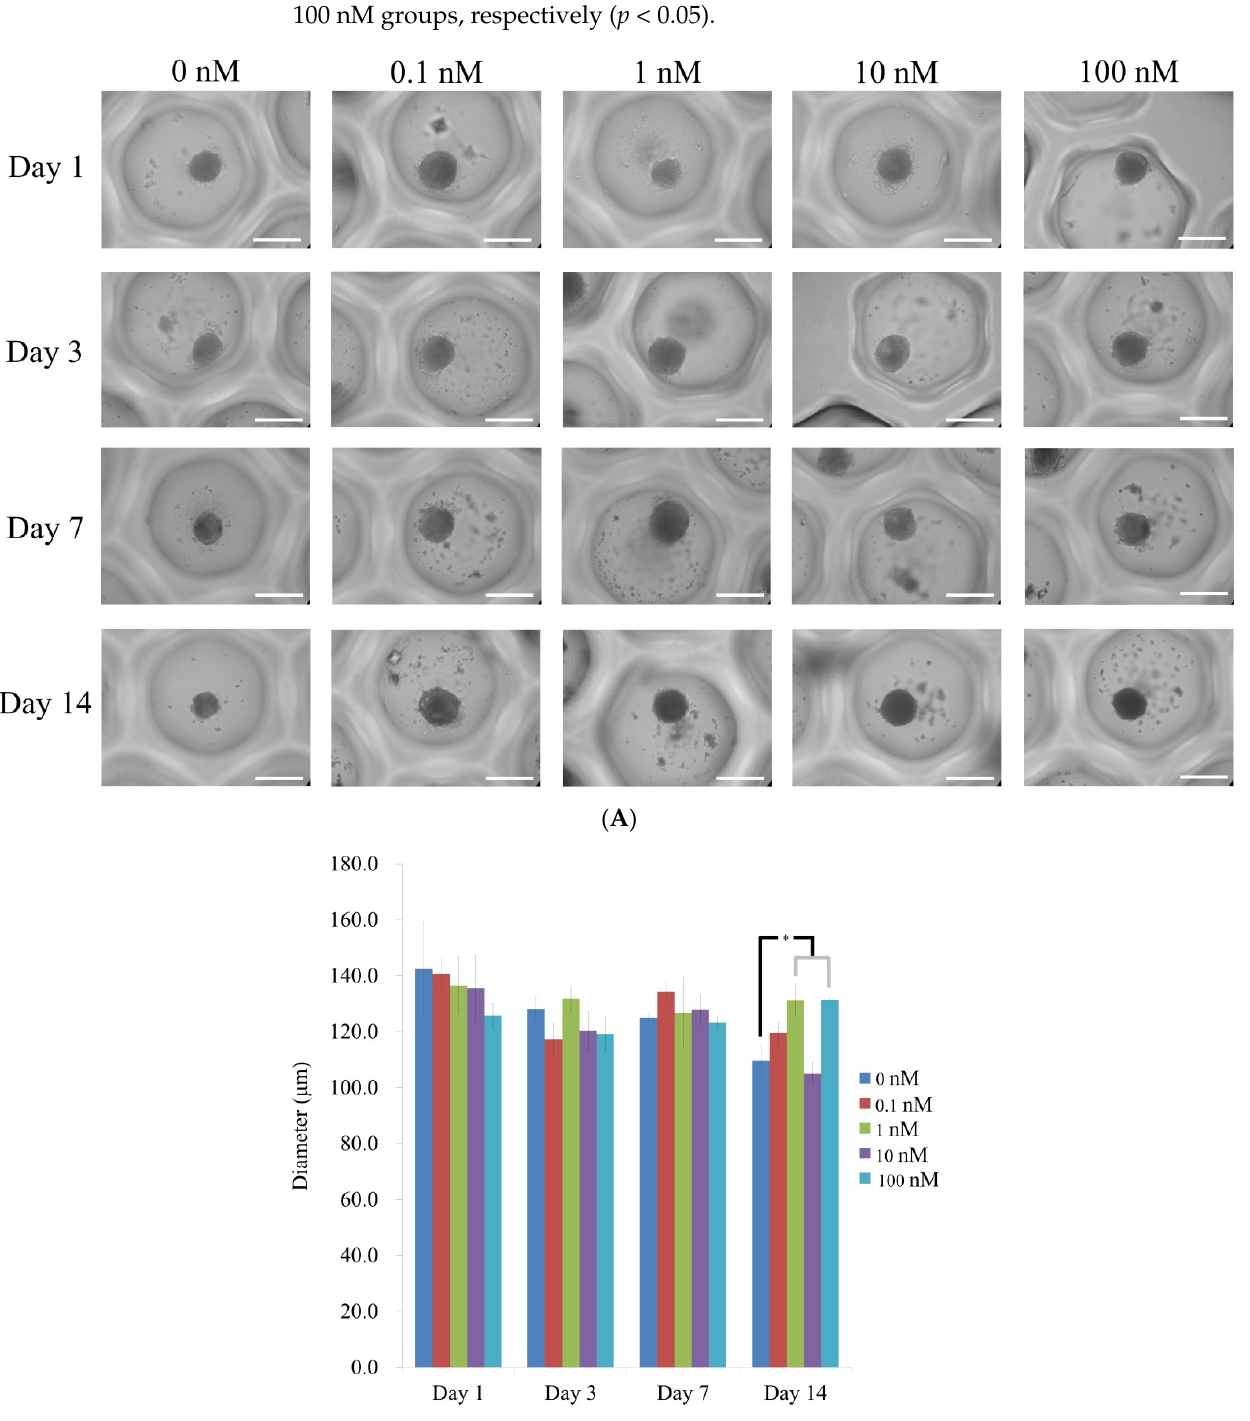
Figure 2. ( A ) The morphologies of stem cell spheroids treated with different concentrations of vitamin D on days 1, 3, 7, and 14. The scale bar represents 200 µm (original magnification ×200). ( B ) The diameters of the stem cell spheroids on days 1, 3, 7, and 14. * p < 0.05 vs. time-matched 0 nM group.